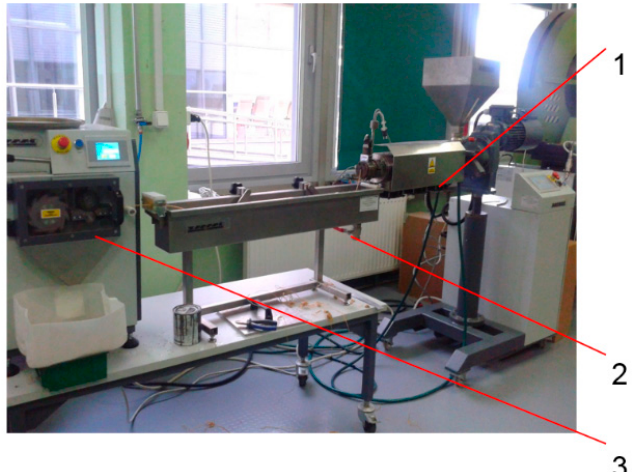
Figure 3. The extrusion line of PHBV- plant origin fiber biocomposites: 1—ZAMAK EHP-25E extruder, 2—cooling bath, 3—granulators. Table 3. Technical data of the ZAMAK EHP-25E extruder (based on [29]).